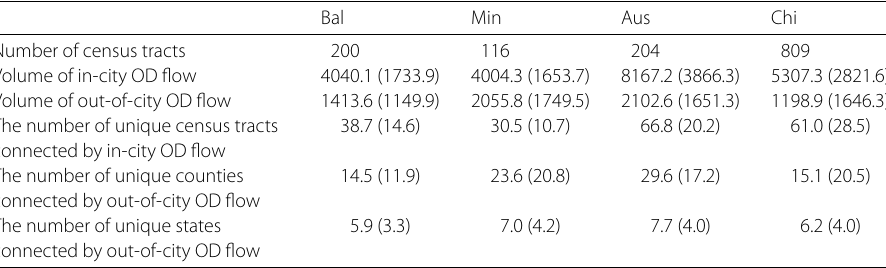
Table 3 Human mobility flow statistics for the four cities under study: Baltimore (Bal), Minneapolis (Min), Austin (Aus) and Chicago (Chi). The numbers in each cell represent the mean (standard deviation) of the daily average across all census tracts in a given city in 2020. OD flows outside the city are flows that either start or end in a census tract that is not part of the city of interest Bal Min Aus